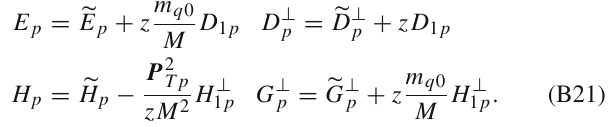
Table 1 Sum rules for the D ⊥ and (cid:2) D ⊥ twist-3 FFs in the parton frame ( f = p ) and in the hadron frame ( f = h ). The flavor index is denoted by an uppercase H to distinguish this from the lowercase h frame index